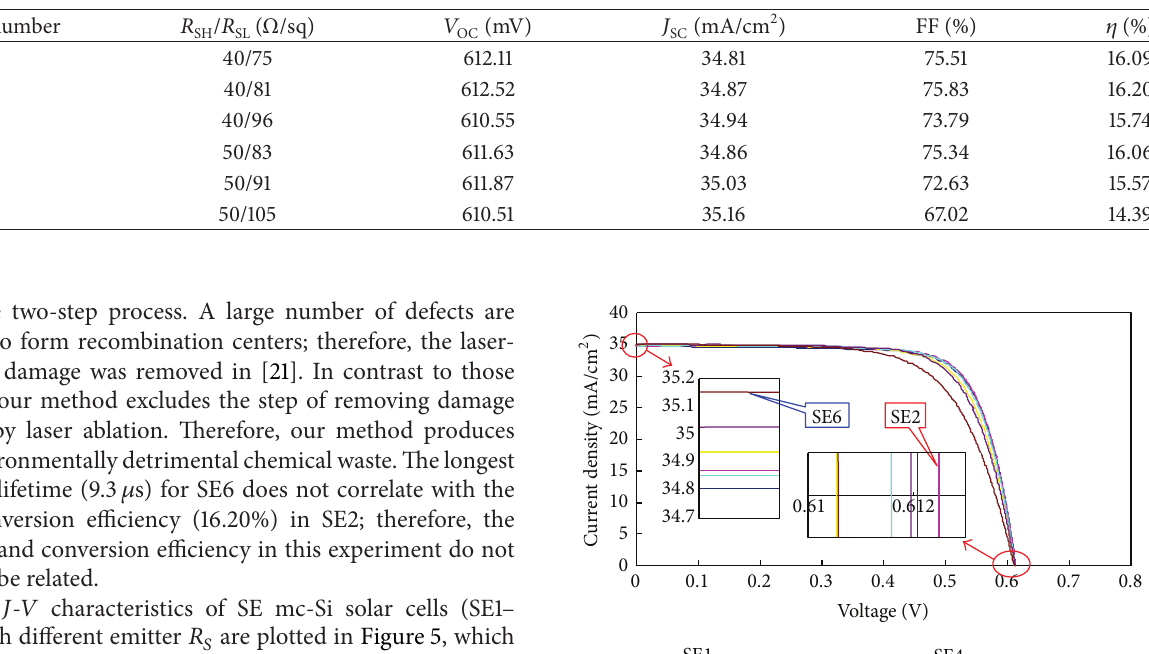
) and lightly doped sheet SH